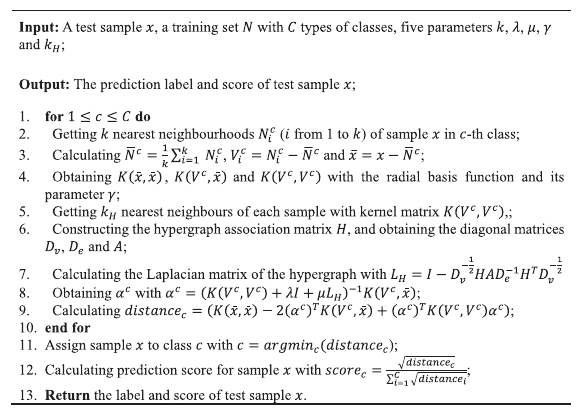
Algorithm 1. Algorithm of